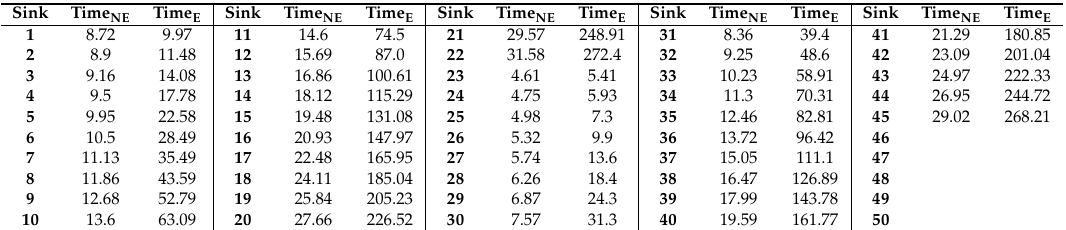
Table 4. Scenario 1: transmission times (in s) for each sink all over the transmission line. (Distance between poles is equal to 100 m, κ = 2, η = 22, η = 23, NE means no encryption, E means encryption.)